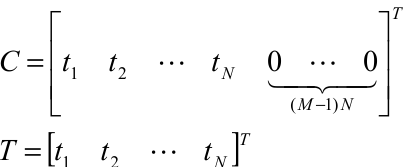
Figure 2. Antenna geometry and direction of a satellite showing calculation of l